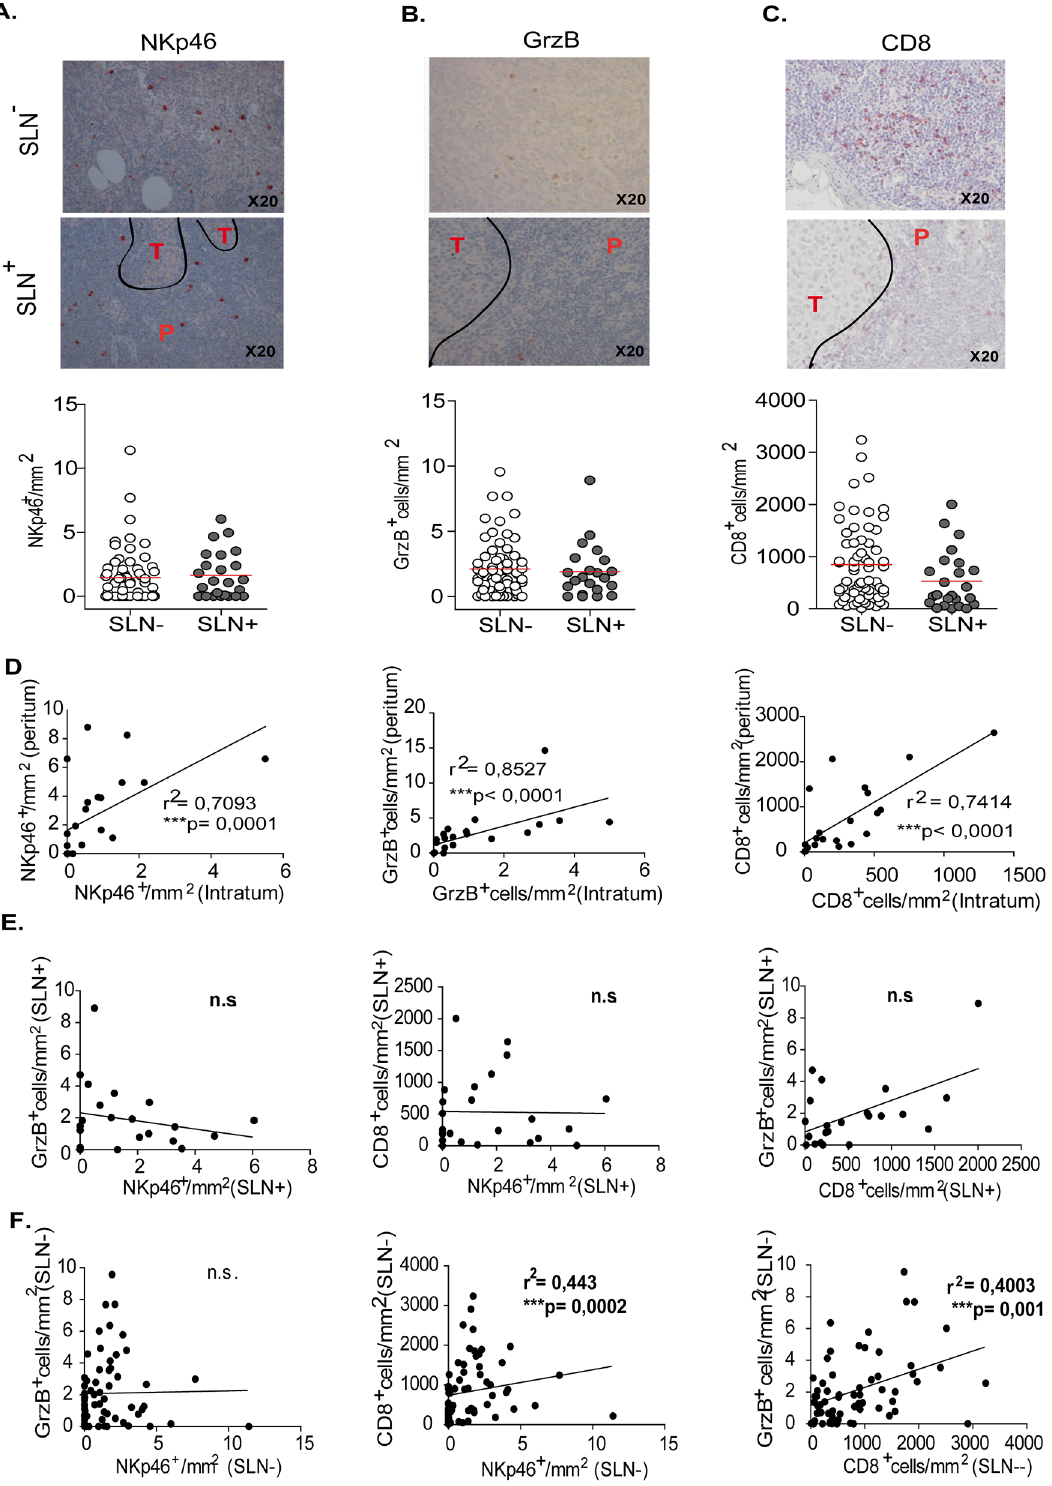
Fig 3. Immunohistological staining and enumeration of cytotoxic cells infiltrating SLN from melanoma patients. Representative staining and counts of immune cells in SLN - and SLN + : (A) NKp46 + NK cells, (B) GrzB + cells, (C) CD8 + T cells. (D) Correlation analyses of NKp46 + cells, GrzB cells and CD8 + T cell numbers between intra- and peritumor area in SLN + . (E, F) Correlation analyses between numbers of cytotoxic immune cells (NKp46 + cells, GrzB + cells and CD8 + T cells) in the SLN + (E) and in the SLN - (F).